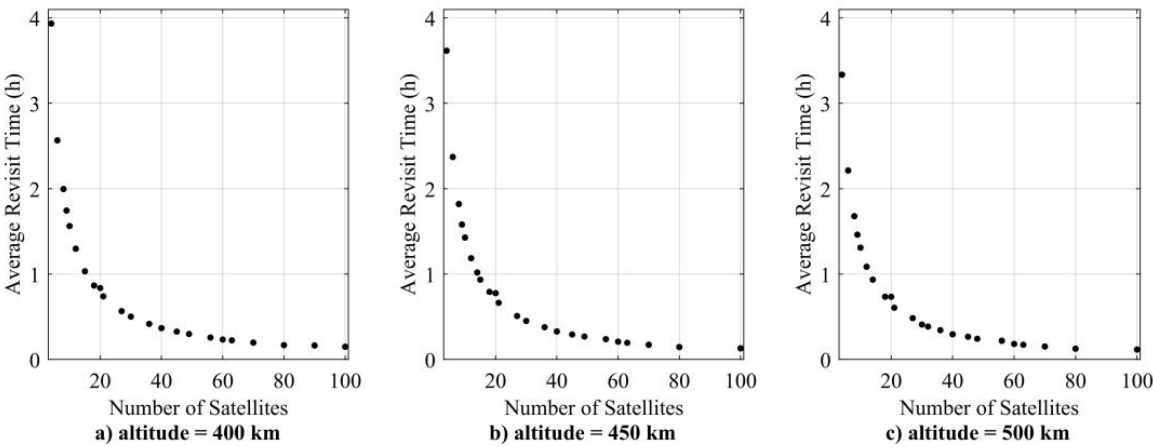
Figure 5. Pareto front for regional target coverage simulation case at different altitudes.